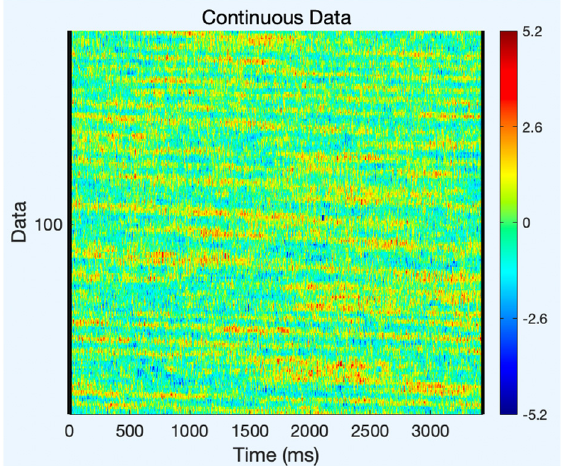
Figure 6. ERP of component 12.